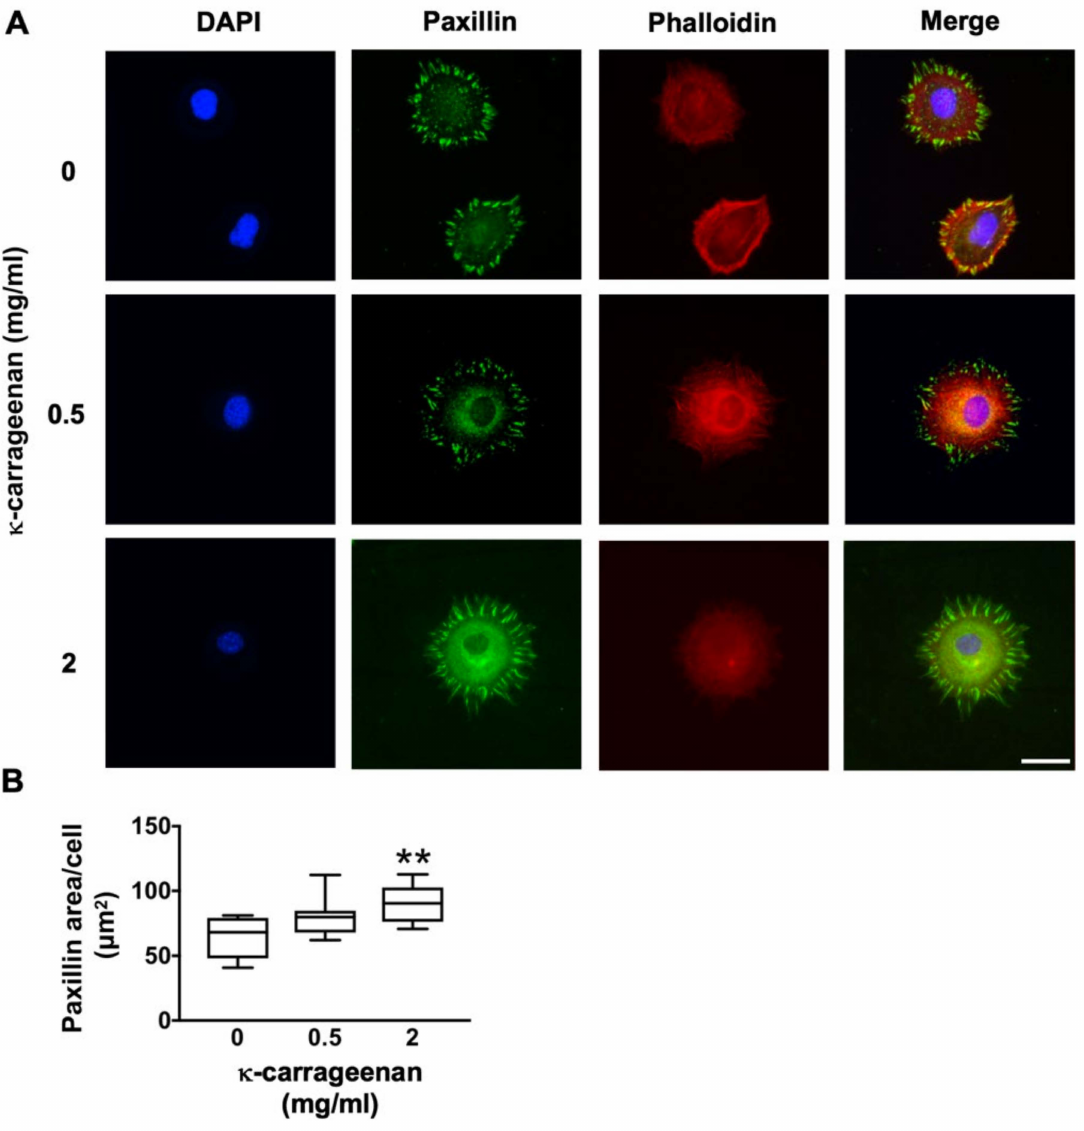
Figure 3. Effect of κ -carrageenan on paxillin expression and distribution in MC3T3-E1 pre-osteoblasts at 2 h. ( A ) Cells stained for DAPI/phalloidin (blue/red) and paxillin (green). Bar: 50 µ m. ( B ) Quantification of paxillin area in untreated control and κ -carrageenan-treated cells. Significant effect of κ -carrageenan, ** p <